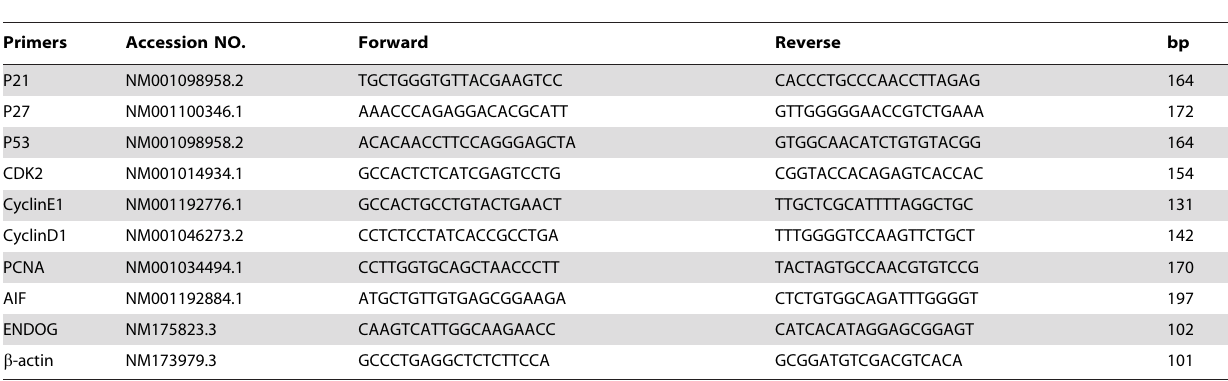
Table 2. Primers used for quantitative real-time